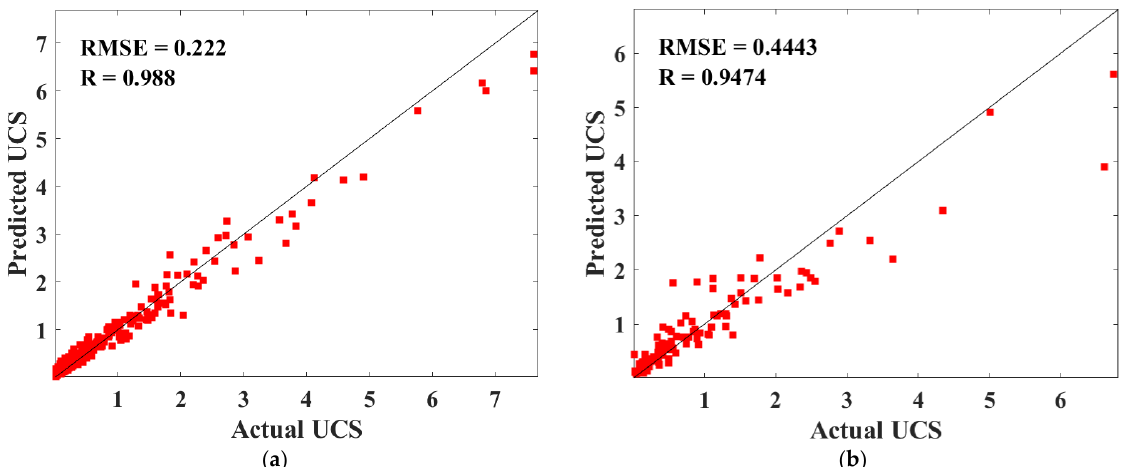
Figure 12. Predicted and actual values for training sets ( a ) and test sets ( b ).